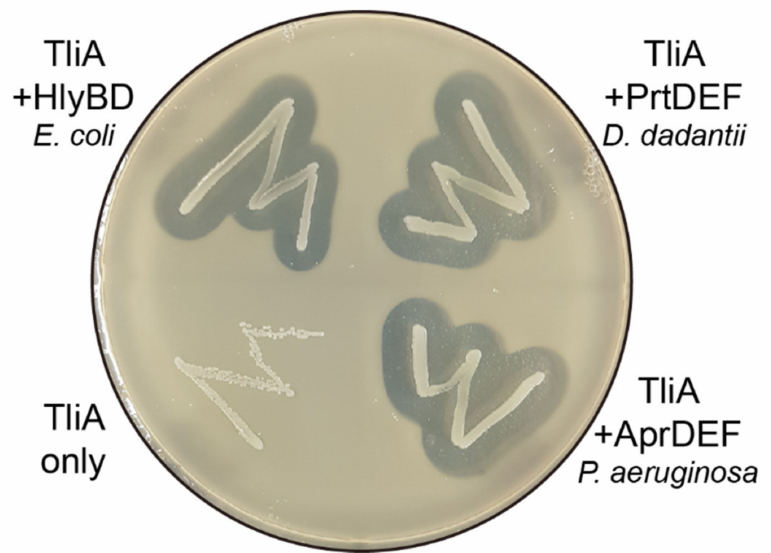
Figure A4. The other bacterial T1SS transporters are compatible with the LARD3 signal sequence used throughout the experiments in this study. Three different bacterial T1SS transporters, P. aeruginosa AprDEF, D. dadantii PrtDEF, and E. coli HlyBD + TolC, can successfully secrete TliA thermostable lipase by recognizing the LARD3 signal sequence naturally present in TliA. The secreted TliA lipase creates a visible halo on the plate lipase activity assay. The negative control colonies only harbor the tliA gene and no genes for the transporters, so the expressed TliA lipase stayed in the cytoplasm and no halo was formed.